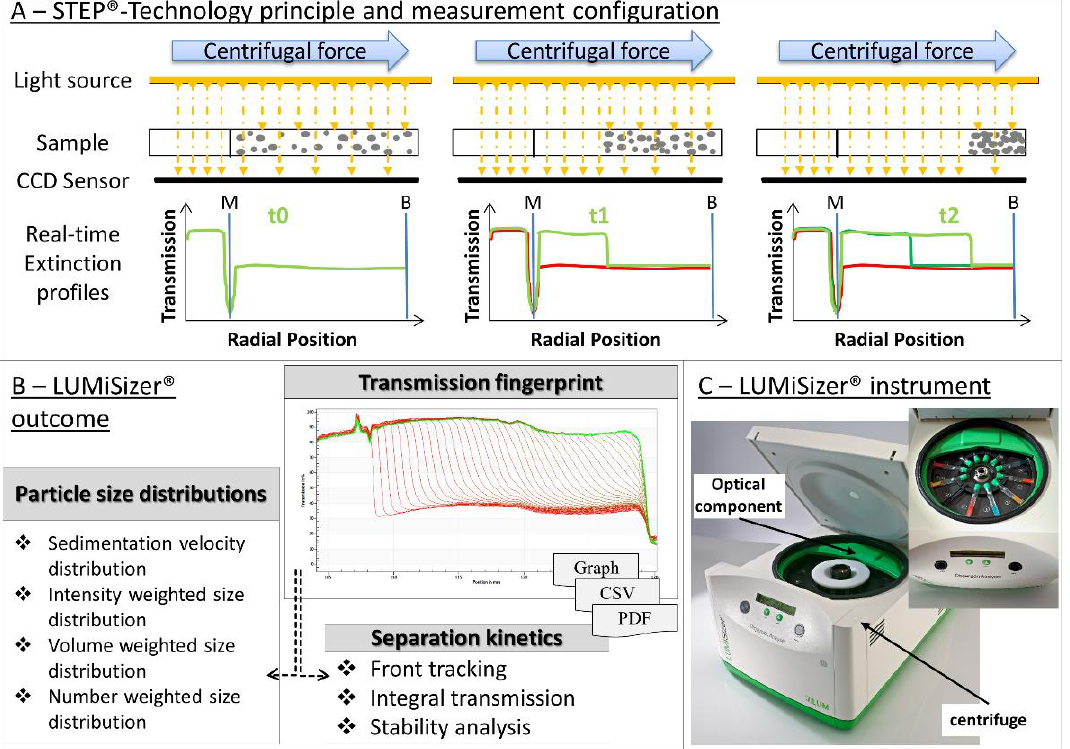
Figure 9. Space- and time-resolved extinction profile (STEP): instrument, measuring principle, and final outcome. ( A ) Schematic illustration of the STEP ® technology measurement principle. The particle suspension is homogenously distributed. Light is applied the over the whole sample and the transmission light is detected behind the sample over the whole lengths. The application of a centrifugal force leads to particle movement from the meniscus M to the cuvette bottom B. The clarification over time and a specific sedimentation velocity can be calculated. ( B ) The direct result achieved is the transmission fingerprint. Based on this various data analysis possibilities are provided by the software. Depending on the information known about the sample particles a wide variety of analysis and data evaluations are possible. The results are obtained as video file, graph image files, text file (.csv), and PDF-file. ( C ) LUMiSizer STEP ® instrument (LUM GmbH) Image adapted with permission from a product of LUM GmbH, 2020.